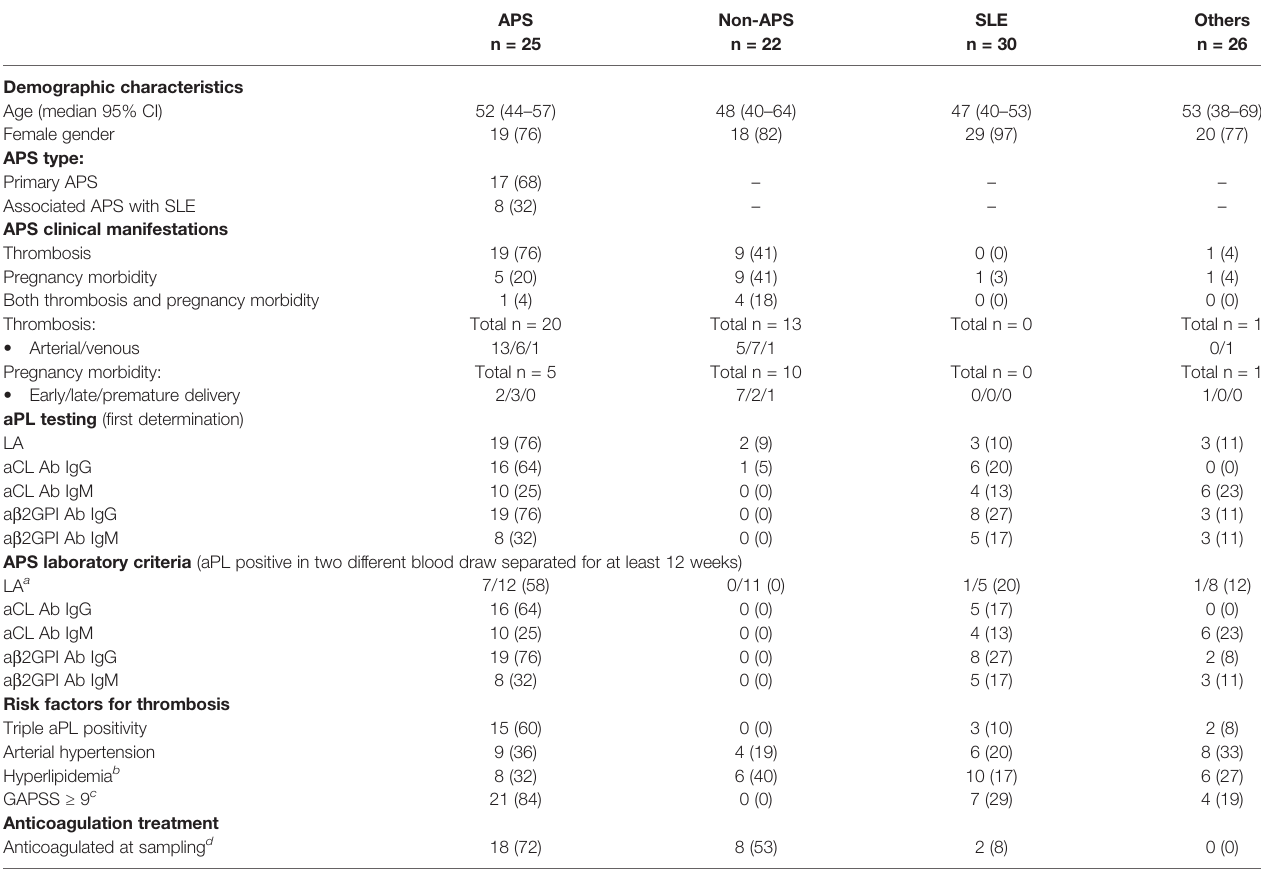
TABLE 1 | Demographic characteristics, clinical manifestations, and APS laboratory features of patients included according to each group.